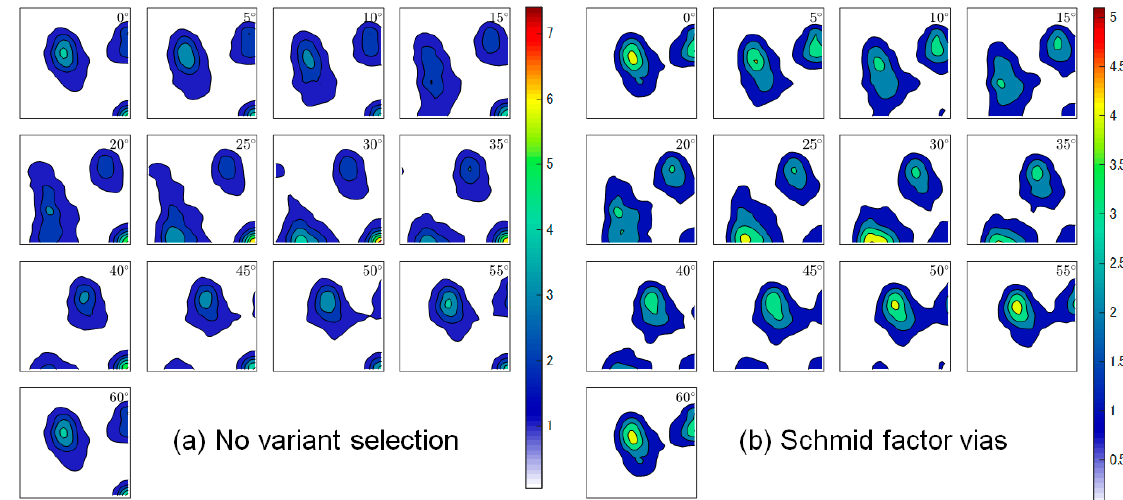
Figure 9. φ 2 sections of the calculated ODF of the ε martensite from the ODF of the austenite at E = 0.42 ( a ) without a variant selection rule and ( b ) with the Schmid-factor-based variant selection.